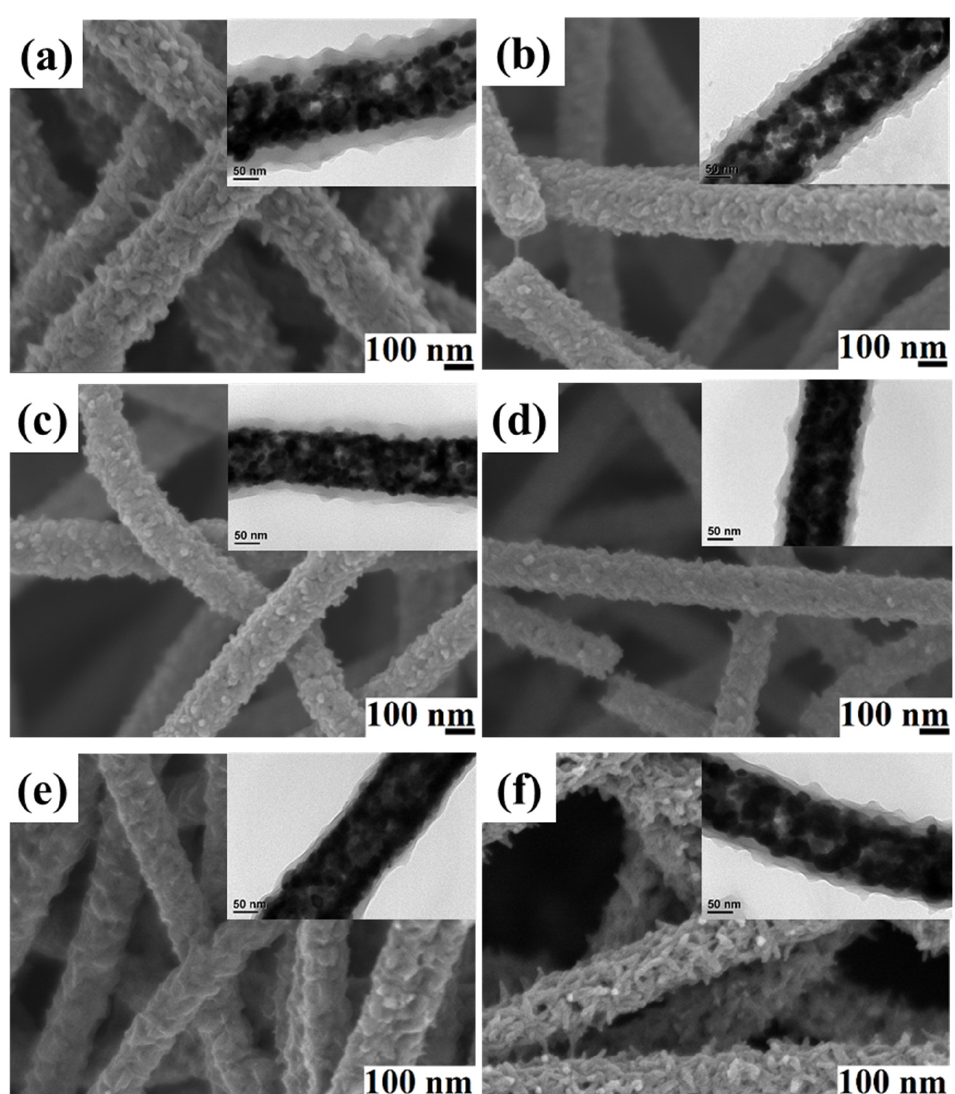
Figure 4. SEM and TEM images of ( a ) 2.5 wt% PANI/hollow In 2 O 3 nanofiber, ( b ) 5 wt% PANI/hollow In 2 O 3 nanofiber, ( c ) 10 wt% PANI/hollow In 2 O 3 nanofiber, ( d ) 15 wt% PANI/hollow In 2 O 3 nanofiber, ( e ) 20 wt% PANI/hollow In 2 O 3 nanofiber, and ( f ) 25 wt% PANI/hollow In 2 O 3 nanofiber composites.